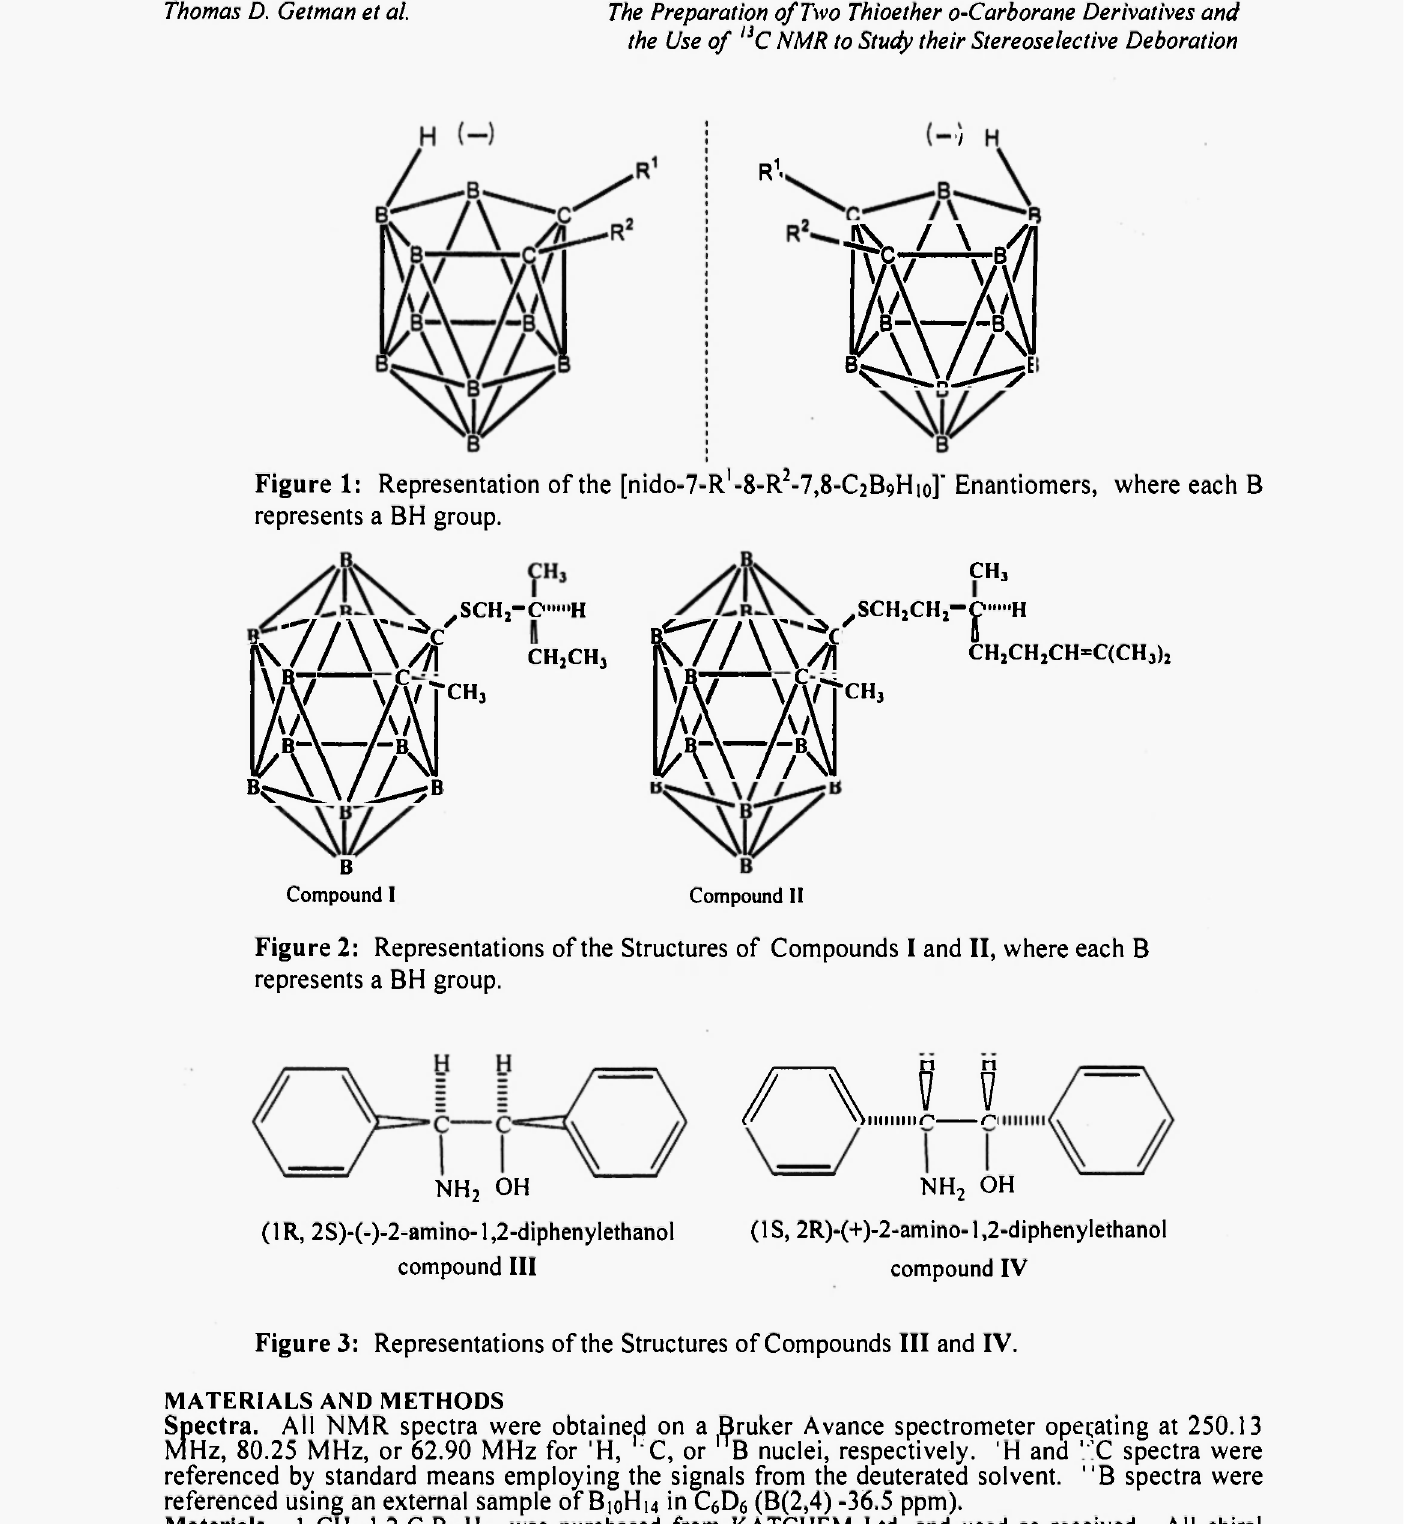
Figure 3: Representations of the Structures of Compounds III and